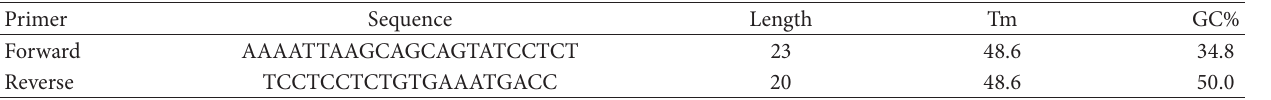
Table 2: Primers designed for XmnI sequencing.